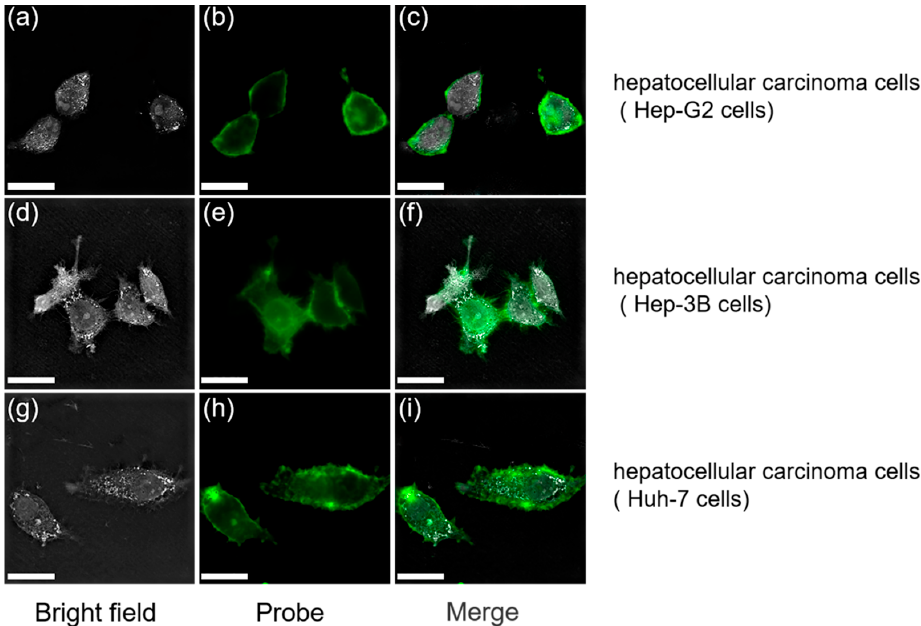
Figure 2. Fluorescence images of hepatocellular carcinoma cells Hep-G2 cells ( a – c ), Hep-3B cells ( d – f ), Huh-7 cells ( g – i ) stained with NDSA-L5 (7 µ M). Overlay imaging. Scale bar, 20 µ m.